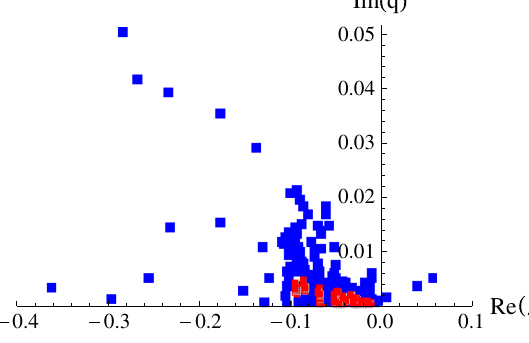
FIG. 11. Same as the previous figure, but for the fractional eigenvalues.